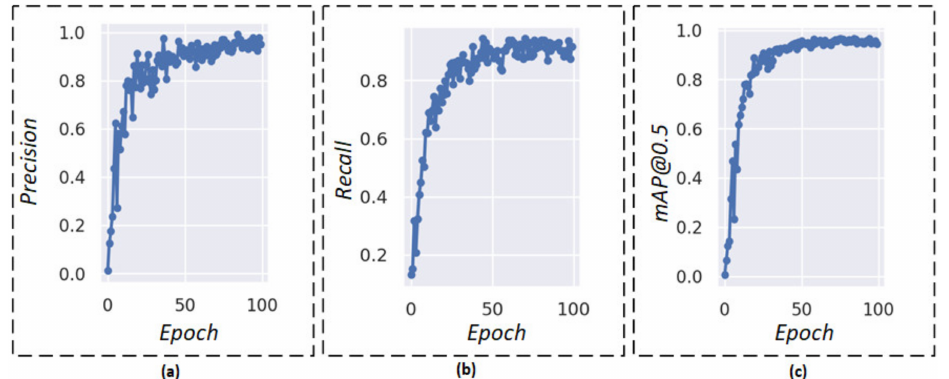
Figure 8. Evaluation indicators. ( a ) Precision result over epoch, ( b ) Recall result over epoch, and ( c ) mAP result over